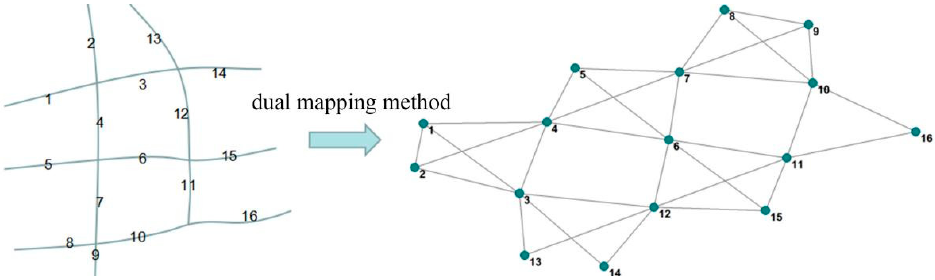
Figure 3. Example of dual modelling method (Source: self-drawn by the author).